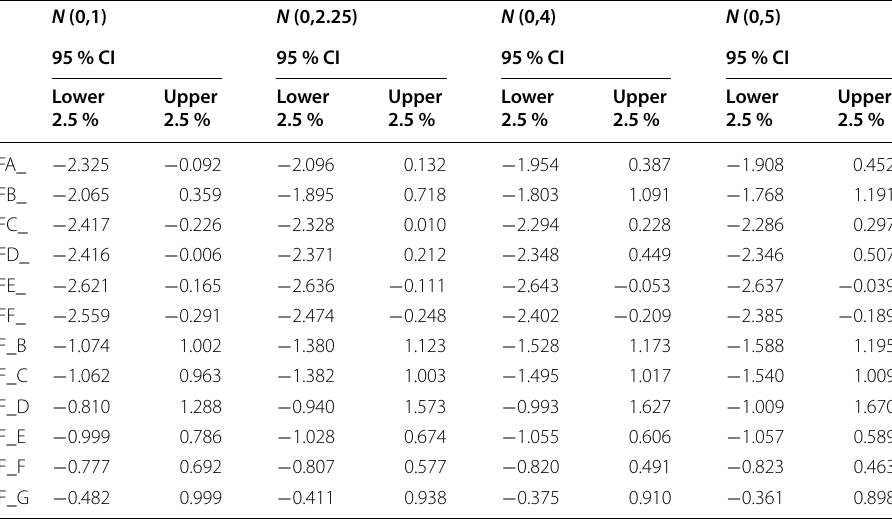
These statistics are based on the average results over 10,000 data sets Table 6 95 % intervals of Japan’s plausible values for each